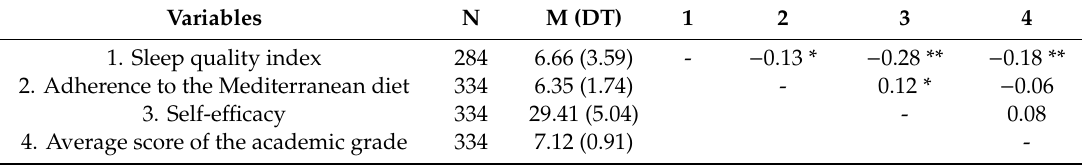
Table 1. Descriptive and bivariate correlations between the di ff erent variables under study.